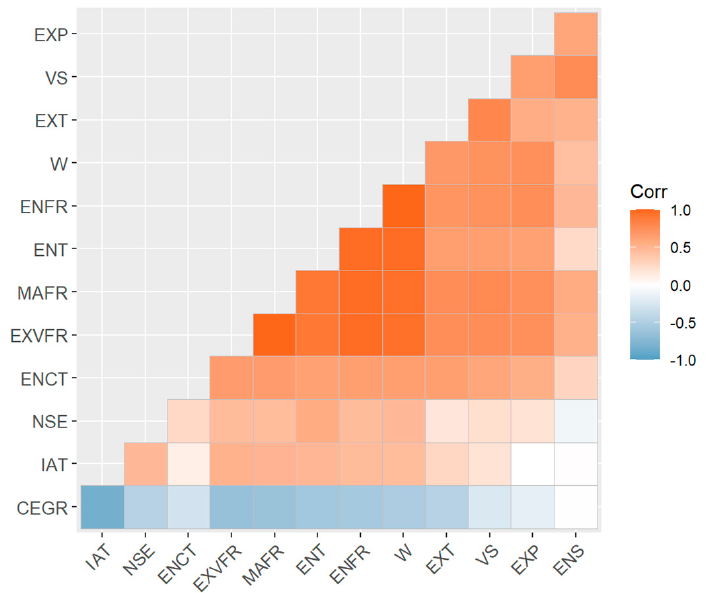
Figure 3. Heatmap of the channel correlation matrix.